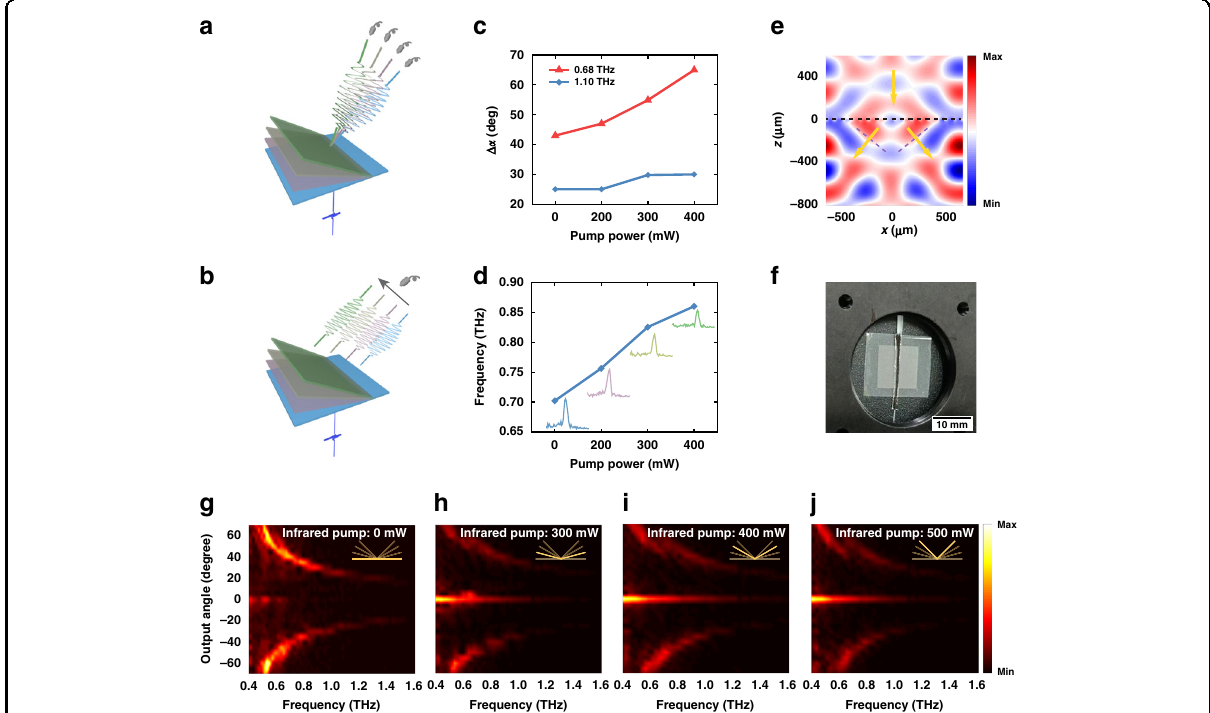
Fig. 4 Application investigation of LCE metasurfaces. a Schematic of the LCE metasurface as a terahertz beam steerer controlled by infrared light. b Schematic of the LCE metasurface as a terahertz frequency modulator when the detection is fi xed at an output angle of 40°. c Variations of the output angle for 0.68 and 1.1 THz when pump power increases from 0 to 400 mW. d Detected center frequencies versus the pump power at 40° output angle. e Simulated beam splitting under normal incidence for 0.8 THz. f Photo of the fabricated LCE beam splitter suspended on the holder. The thick black line in the middle indicates where the infrared light impinges. g – j Frequency-resolved beam splitting behavior under different pump power. The insets indicate the de fl ection of the